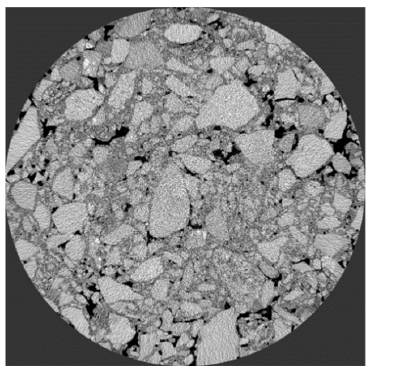
Figure 17. Distribution of void and crack before and after upper splitting of specimen.